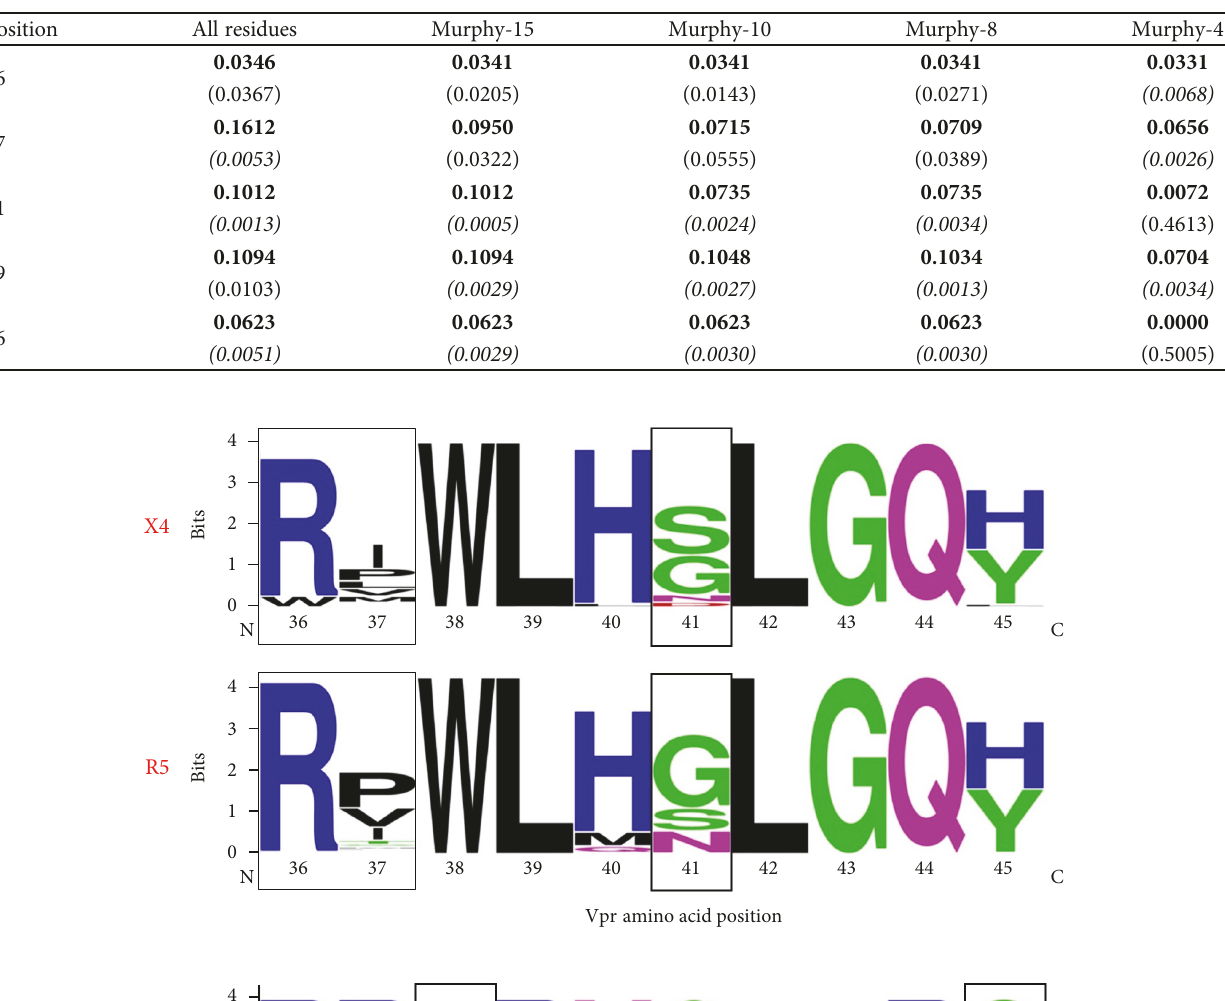
Table 3: HIV-1 Vpr positions with high Jensen-Shannon divergence between R5- and X4-associated sequences. The calculated Jensen- Shannon divergence, along with the associated P value in parentheses (in italics when P < 0 01 ), is displayed for positions 36, 37, 41, 89, and 96.